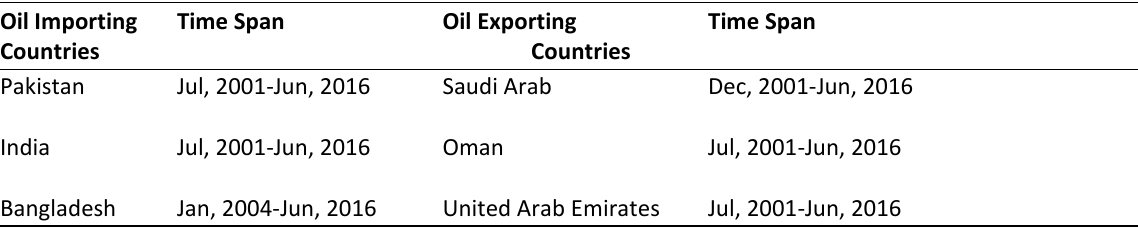
Table 1. Time span used for the analysis.